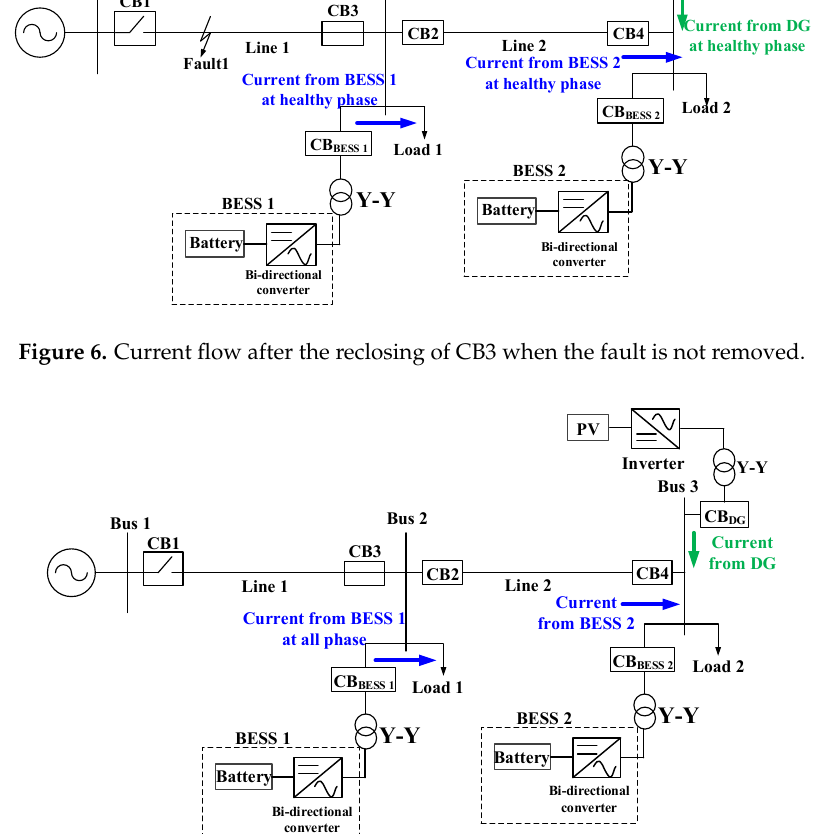
Figure 7. Current flow after the reclosing of CB3 when the fault is removed.